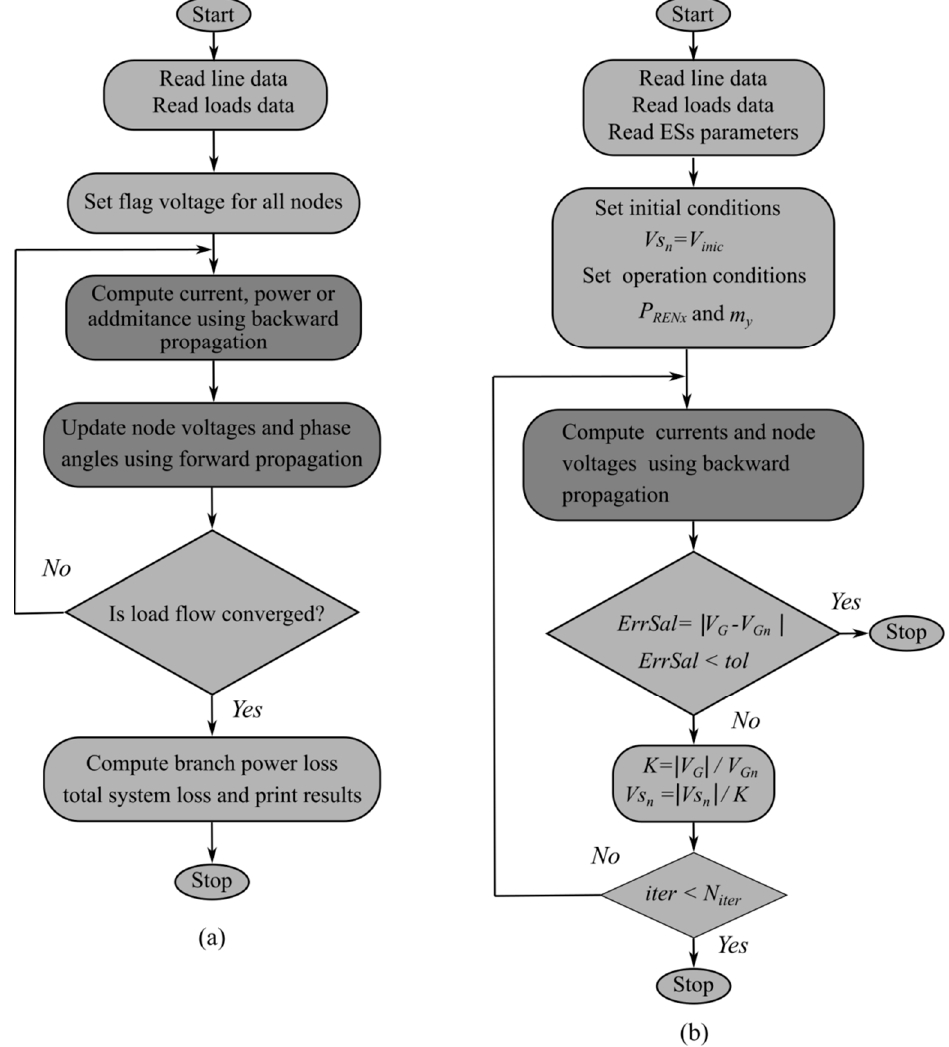
Figure 6. Backward–forward sweep method (BFSM) flowcharts: ( a ) traditional algorithm and ( b ) modified algorithm.